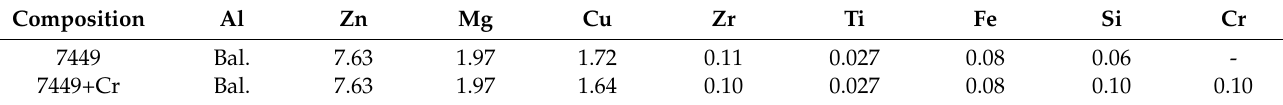
Table 1. Composition of alloys (in wt.%).